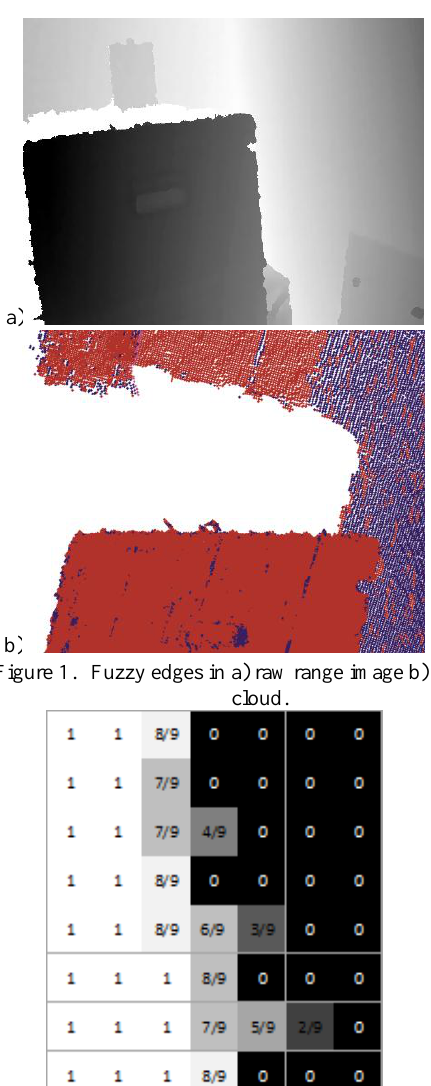
Figure 2. Accuracy field values based on number of null neighbor pixels with 0 as null pixel and most accuracy value of 1 as a pixel with no null neighbor.